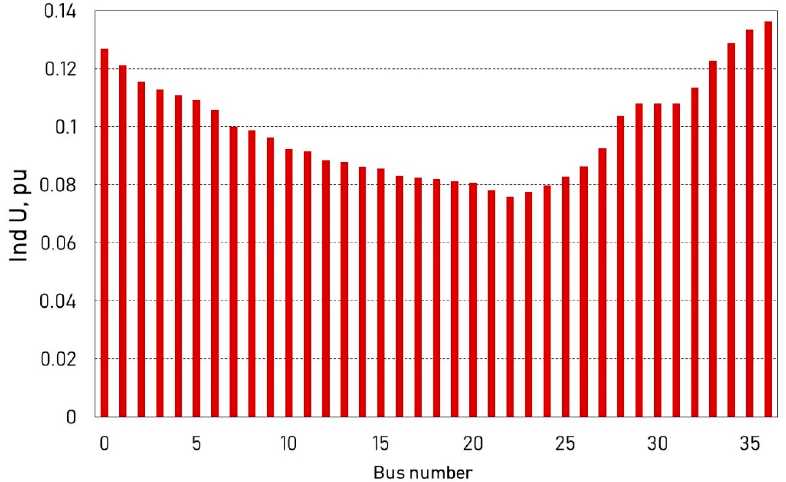
Figure 17. Simulation results determining the voltage quality index averaged for the entire year depending on the selection of the internal reference node.